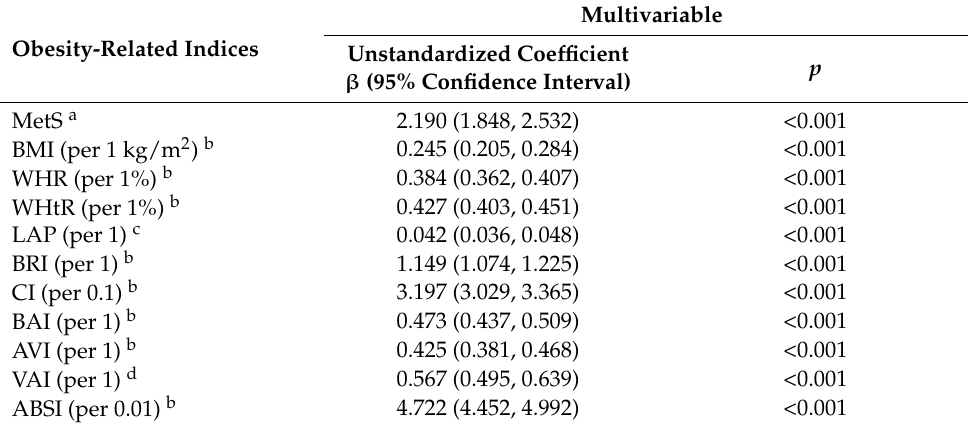
Table 4. Association of MetS and obesity-related indices with baseline eGFR using multivariable linear regression analysis in all study participants ( n =